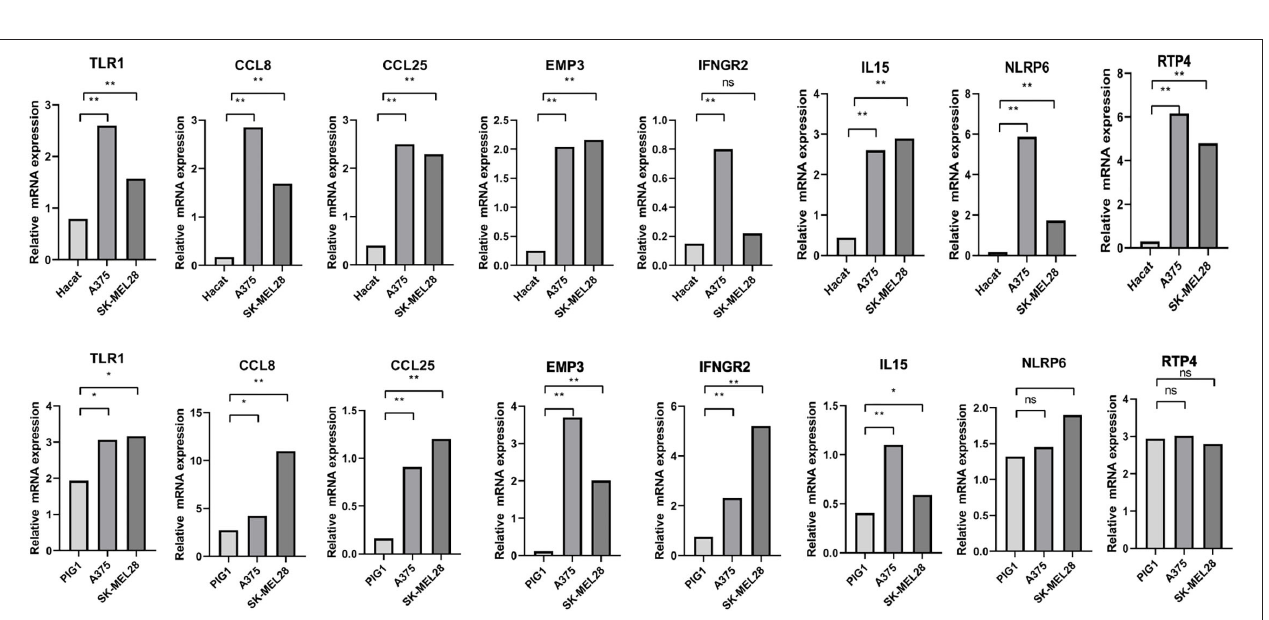
FIGURE 10 | Verification of the protein expression of genes in the GRIP signature. Images from the Human Protein Atlas show the protein expression of IFNGR2, CCL25, IL15, NLRP6, and RTP4 in CM tissues and normal tissues. ** p < 0.01.